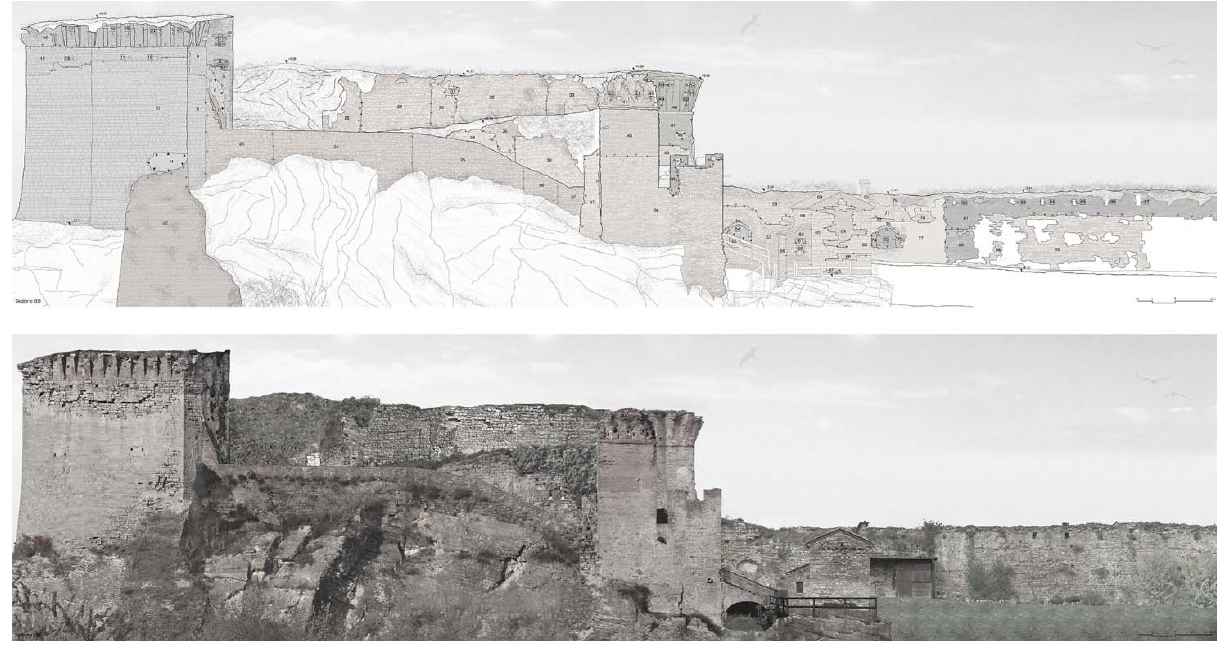
Figure 3. Castrocaro, photogrammetry and sections of S side (surveyors S. Iosca, E.